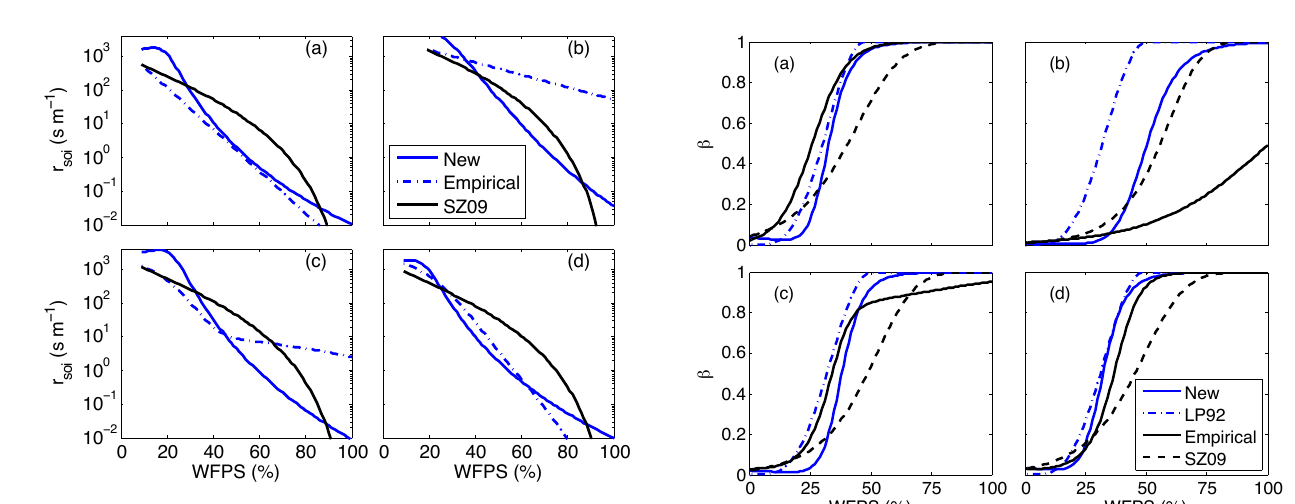
predicted the typical two-stage behavior of soil evaporation, where in stage-I, the soil evaporates at potential evaporation, and in stage-II, the soil evaporates at lower rate than the po- tential evaporation. The empirical soil resistance parameter- ization by Sellers et al. (1992) (Fig. 3b) does not